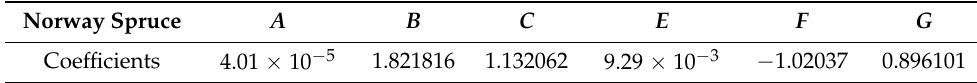
Table 2. The parameters used in Equation (6). Norway